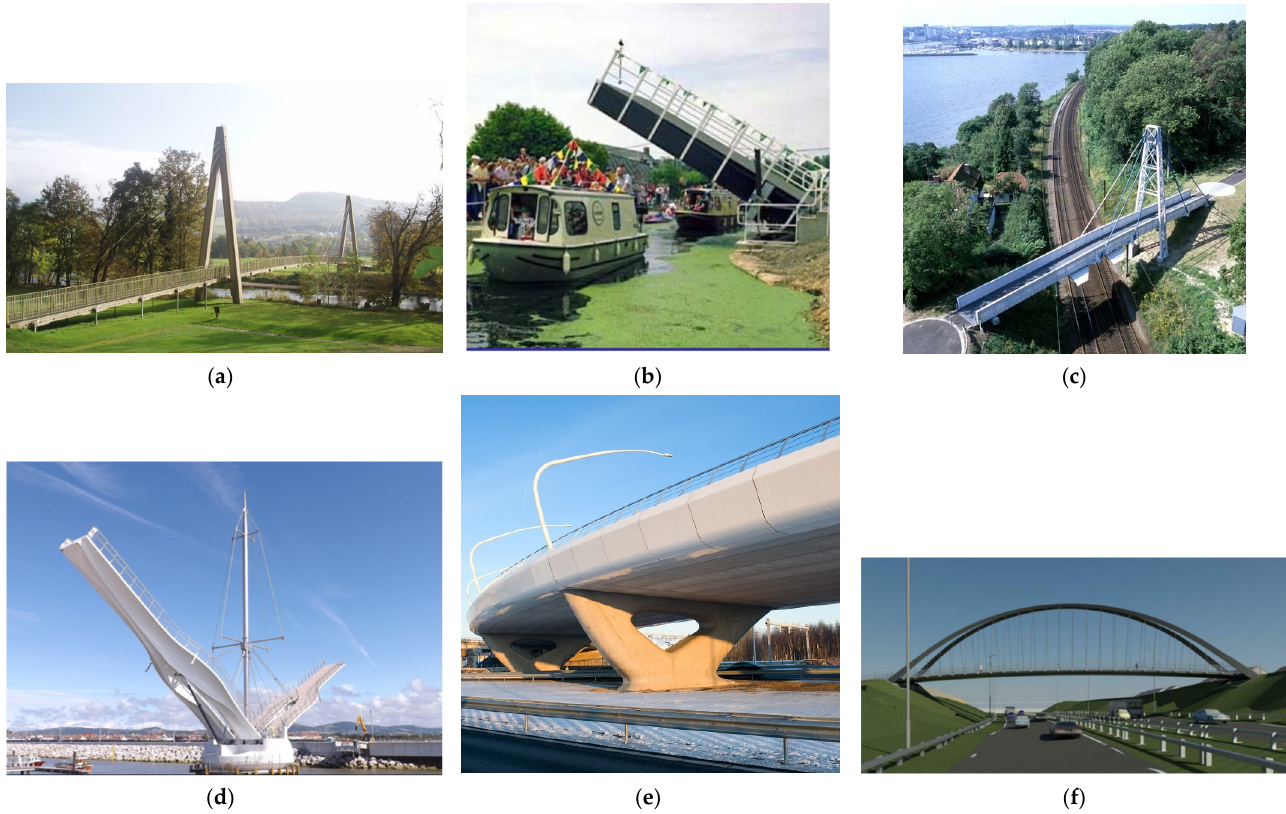
Figure 3. Applications of FRP in bridges: ( a ) Aberfeldy Scotland footbridge [35]; ( b ) Bonds Mill lifting bridge [36]; ( c ) Kolding Denmark FRP pedestrian bridge, 1997 [9,37]; ( d ) The Pont y Ddraig, the Dragon bascule bridge in Wales, 2013 [38]; ( e ) Fly-over Waarderpolder bridge in Netherland with FRP edge elements [39]; ( f ) Emersons Green Cycle Footbridge, Bristol UK [40].